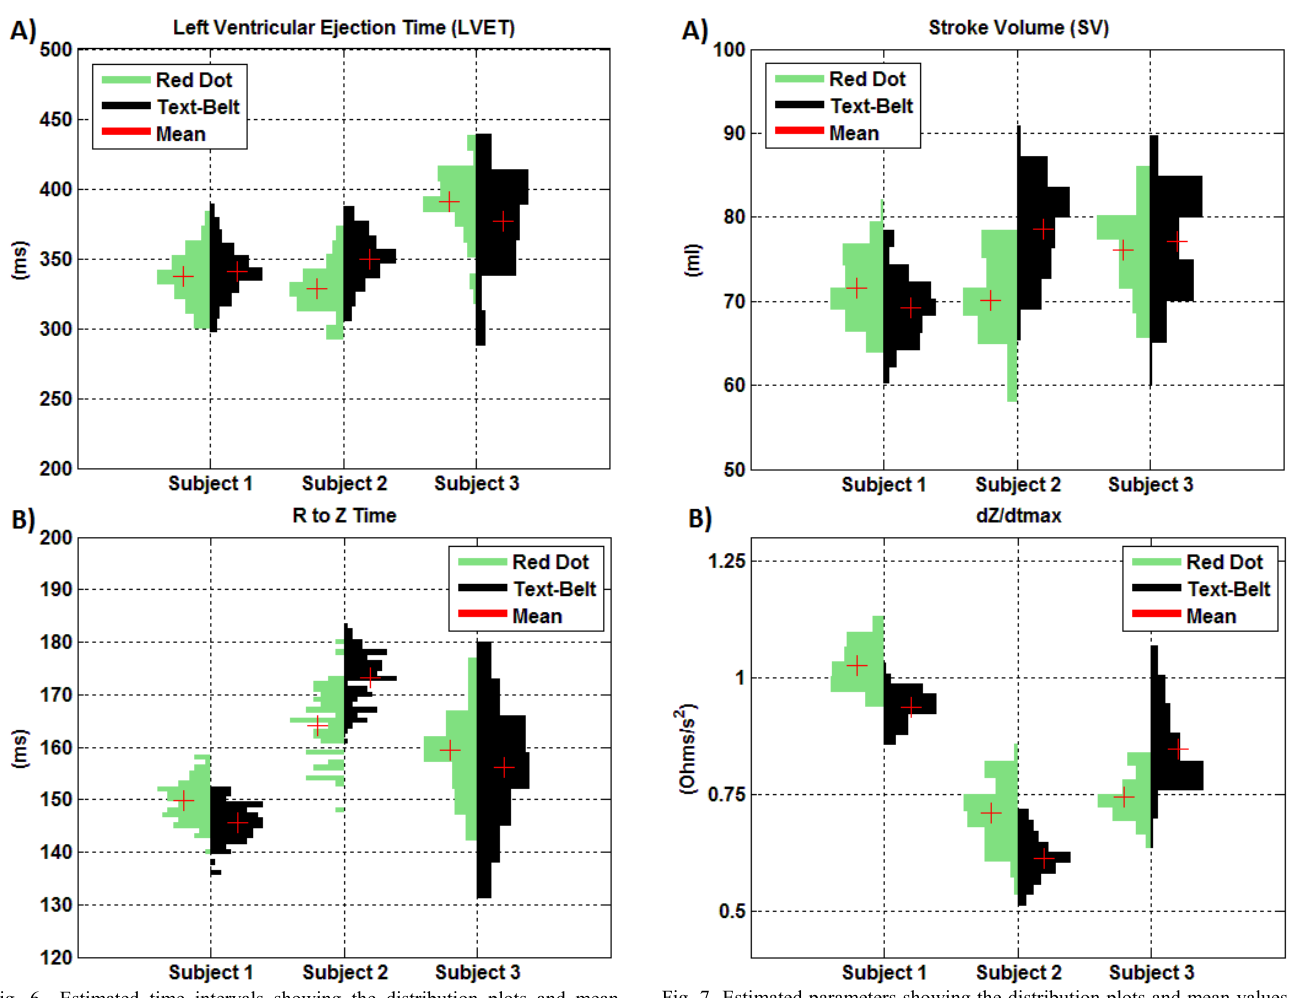
Fig. 6 Estimated time intervals showing the distribution plots and mean values. (A) Left ventricular ejection time and (B) characteristic period R to Z time.